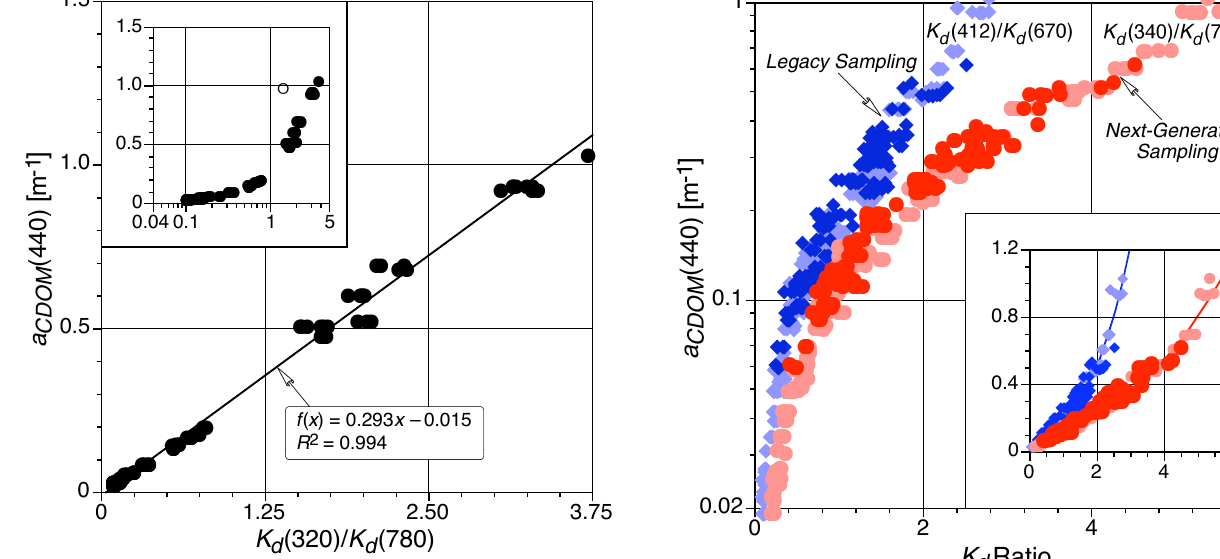
JJJJ JJ JJJ JJJ JJJJ JJ